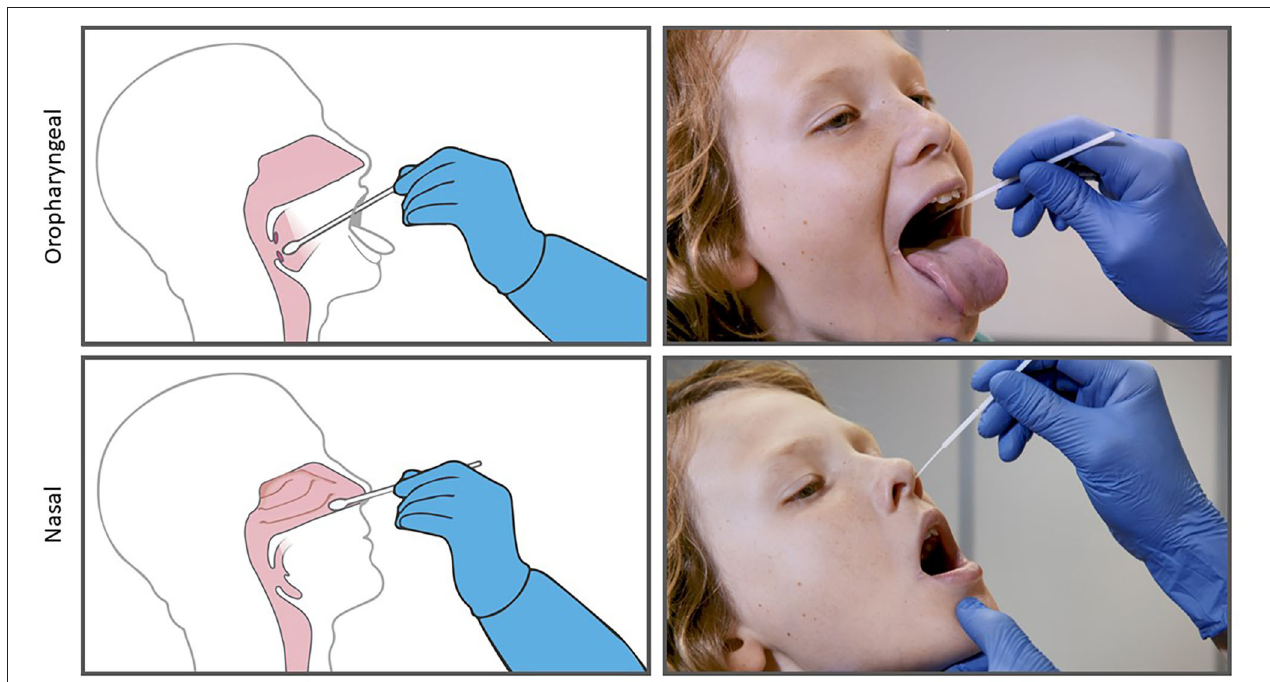
FIGURE 1 | Combined oropharyngeal and nasal (OP/Na) swabbing with a single fine flexible shaft flocked